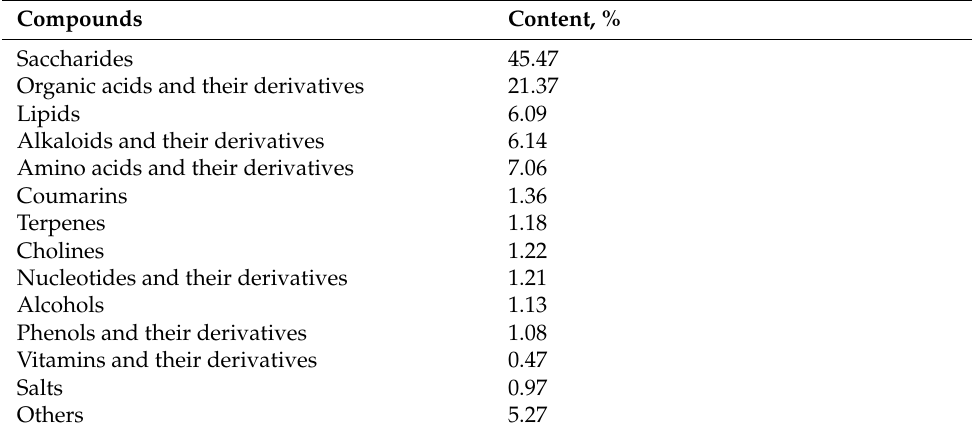
Table 1. Compound contents of NFP (%, DM